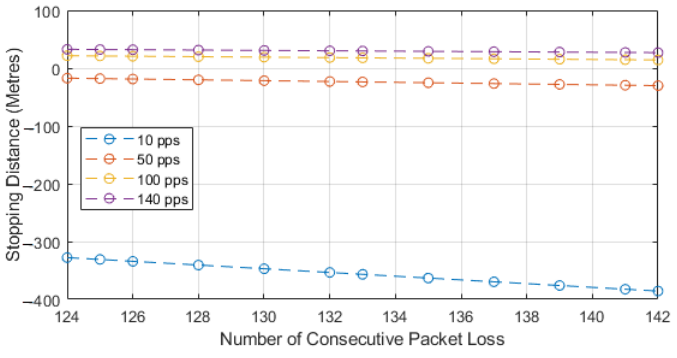
Figure 23. Joint loss—100% density